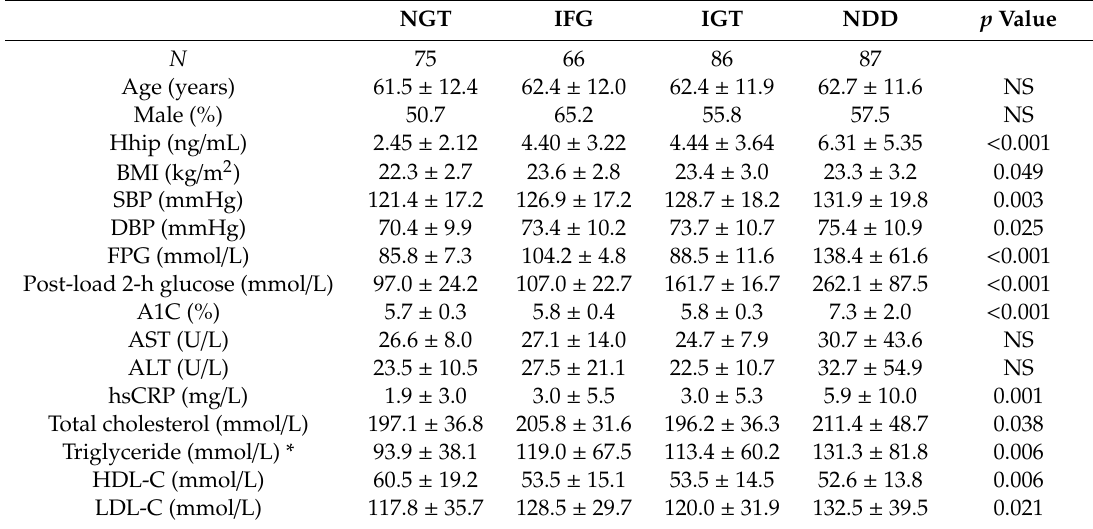
Table 1. Comparisons of clinical parameters among subjects with normal glucose tolerance (NGT), impaired fasting glucose (IFG), impaired glucose tolerance (IGT), and newly diagnosed diabetes (NDD).